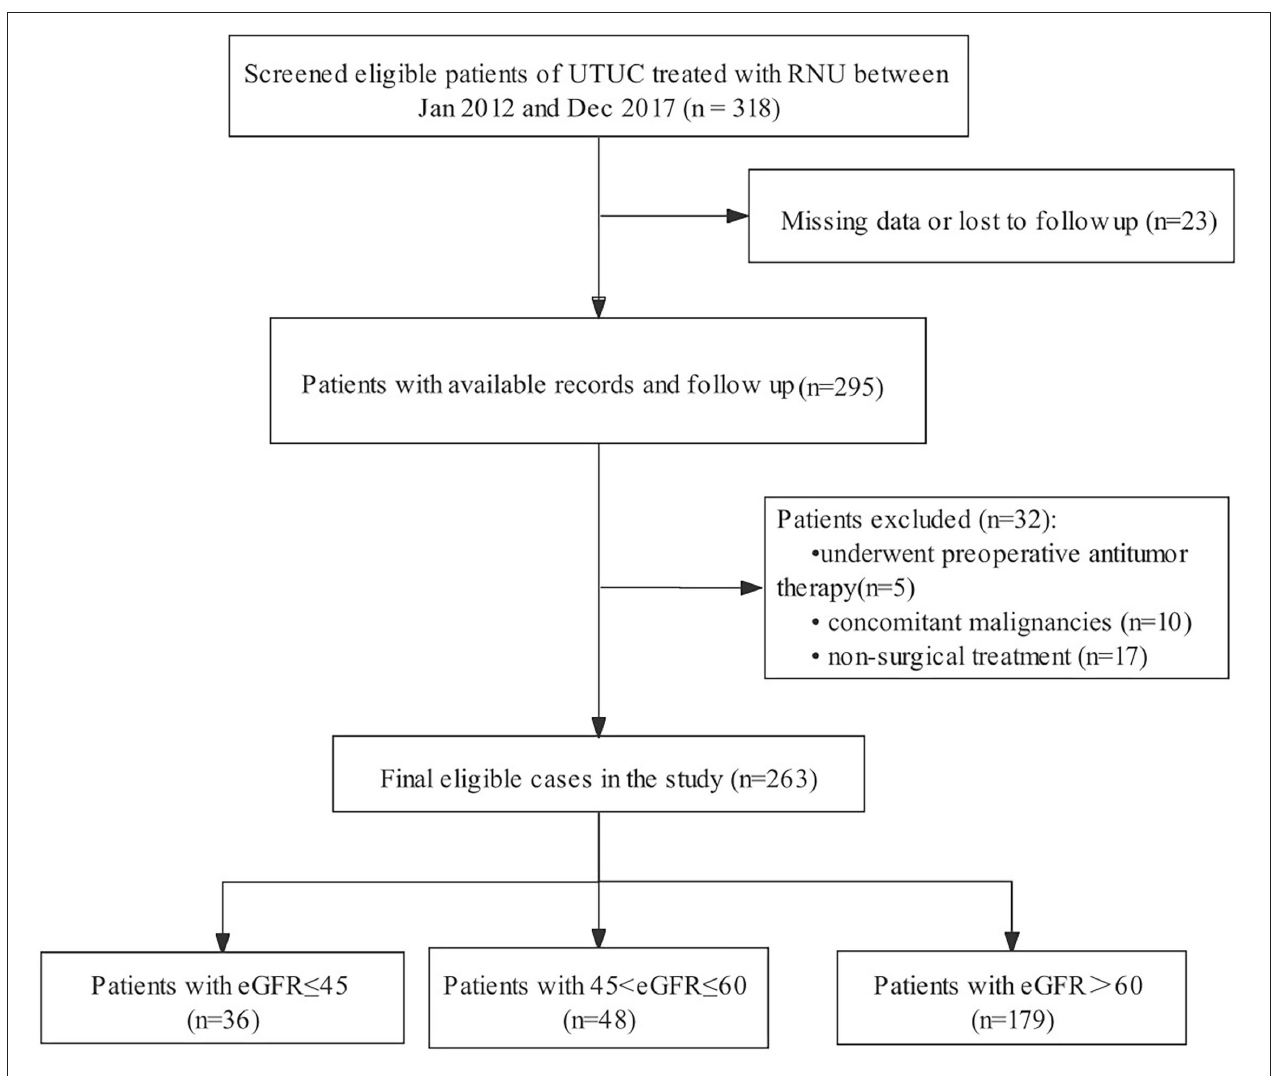
FIGURE 1 | Patient selection